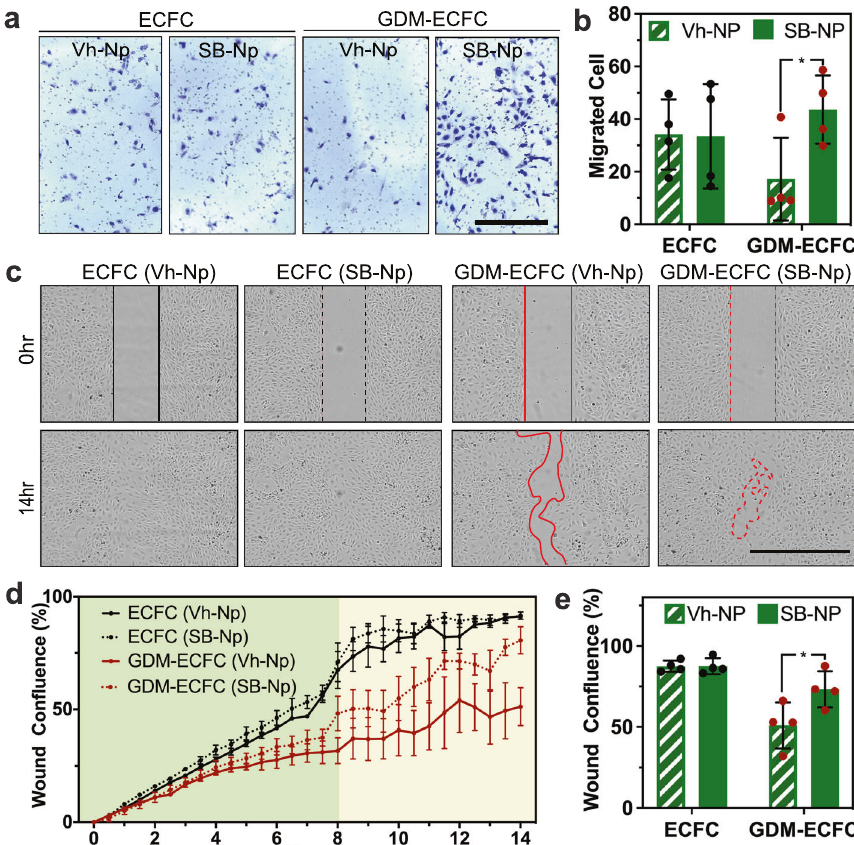
Fig. 4 Bioactive nanoparticles improve cell migration. a Transwell migration assays were performed with normal ECFCs and GDM-ECFCs conjugated with Vh-NPs or SB-NPs. Photomicrographs depict migrated ECFCs stained with crystal violet. Scale bar is 1 mm. b The number of migrating cells after 4 h were quanti fi ed. Four biological replicates ( n = 4; mean ± s.d.) were used for normal ECFCs ( black data dots) and GDM-ECFCs ( red data dots). SB-NPs signi fi cantly improve cell migration of GDM-ECFCs (* P = 0.039), but not normal ECFCs ( P = 0.955). c Wound healing assays were performed with normal ECFCs and GDM-ECFCs treated with Vh-NPs or SB-NPs. High contrast bright fi eld images depict migrated ECFCs at 0 h and 14 h post wound initiation. Scale bar is 1 mm. d Kinetic wound con fl uence curves indicate wound closure for normal ECFCs and GDM-ECFCs treated with Vh-NPs or SB-NPs (mean ± s.d.). e Quanti fi cation of wound con fl uence at 8 h post wound initiation. Four biological replicates ( n = 4; mean ± s.d.) were used for normal ECFCs ( black data dots) and GDM-ECFCs ( red data dots). SB-NPs signi fi cantly improve wound closure of GDM-ECFCs (* P = 0.048), but not normal ECFCs ( P = 0.988). Statistical signi fi cance was evaluated using Student ’ s t -test. Signi fi cance levels were set at * P < 0.05, ** P < 0.01, *** P <